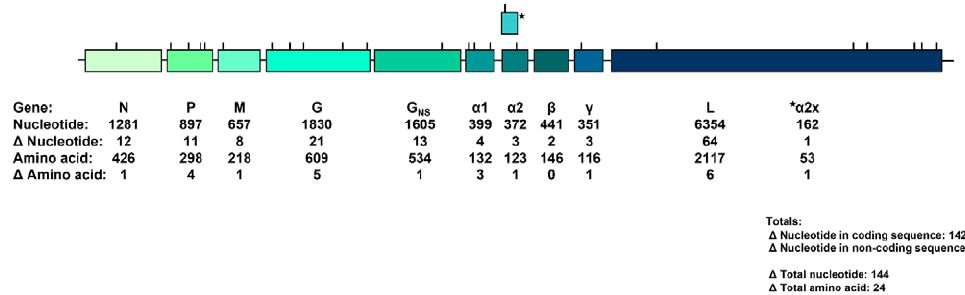
Figure 3. Nucleotide maximum-likelihood phylogenetic tree with 1000 bootstrap replications com- paring the two reported Yata virus isolates to other known ephemeroviruses and rooted with Peri- net virus (genus Vesiculovirus ). The current isolate, 12209, is boxed in red. GenBank accession num- bers: Hayes Yard virus—MH507506.1, Puchong virus—MH507505.1, Kimberley virus— NC_025396.1, Bovine ephemeral fever virus—MW512963.1, Berrimah virus—NC_025358.1, Ade- laide River virus—NC_028246.1, Obodhiang virus—NC_017685.1, Yata virus (UG12209)— ON375848.1, Yata virus (DakArB 2181)—NC_028241.1, New Kent County virus—MF615270.1, Koolpinyah virus—NC_028239.1, Kotonkon virus—DQ457099, Perinet virus—NC 025394.1. 4. Discussion We report the isolation of a little studied ephemerovirus, YATAV. As only the second known isolation of this virus, 48 years removed from the original, this isolation offers an opportunity to examine the change over time of the YATAV genome. Rhabdoviruses are known to mutate quickly due to an error-prone RNA-dependent RNA polymerase and adaptation resulting from selective pressures [15,16]. While the rate of evolution of most ephemeroviruses remains unclear [6], BEFV was found to have an evolutionary rate of approximately 10 −3 substitutions/nucleotide/year (s/n/y) [17]. The current YATAV isolate differs by less than 1% at the nucleotide level from the original isolate, despite the